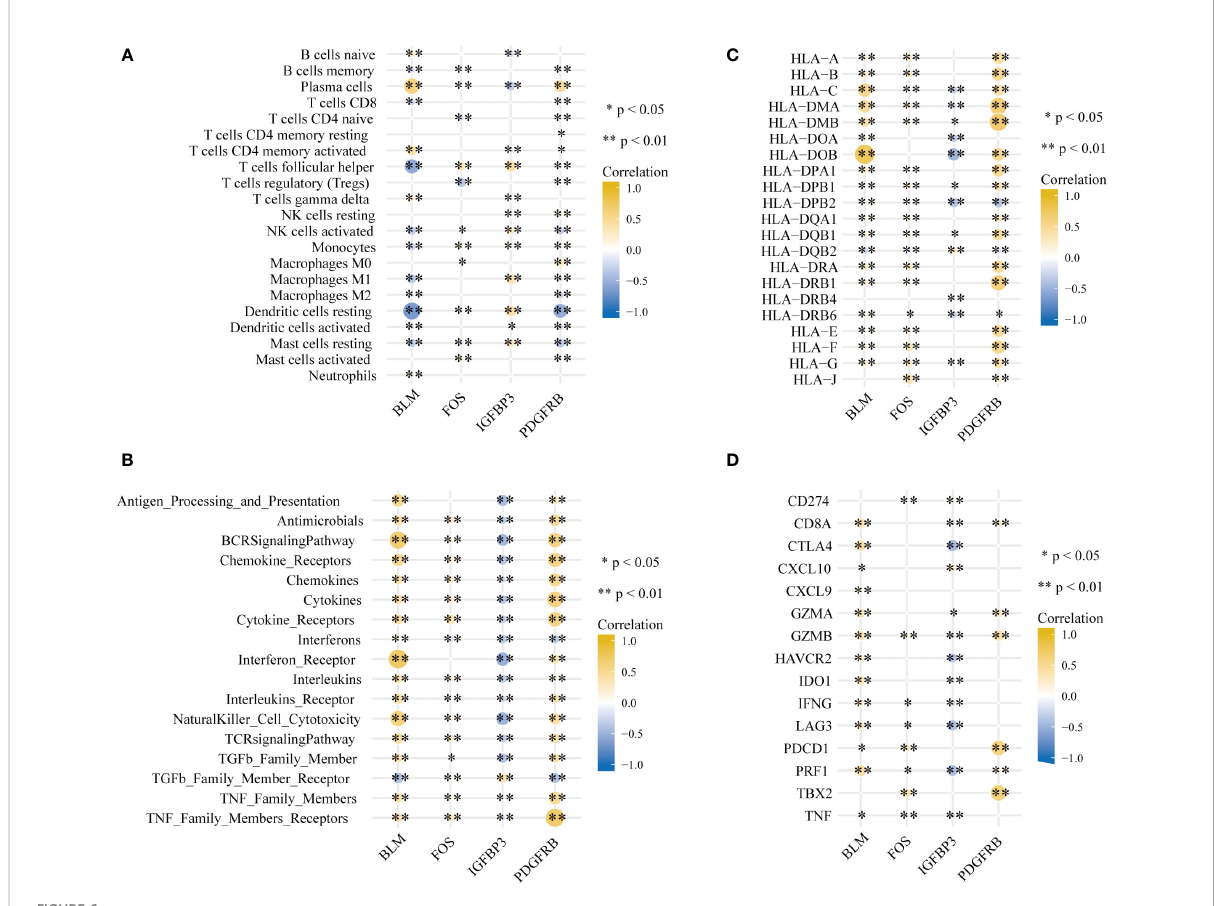
FIGURE 6 Signatures associated with immune in fi ltrations in PD. (A) Correlation coef fi cients between the immune cell in fi ltrations, (B) the enrichment scores of immune reaction, (C) the expression of HLA gene and (D) immune checkpoints and four hub aging-related genes (*p < 0.05, **p <